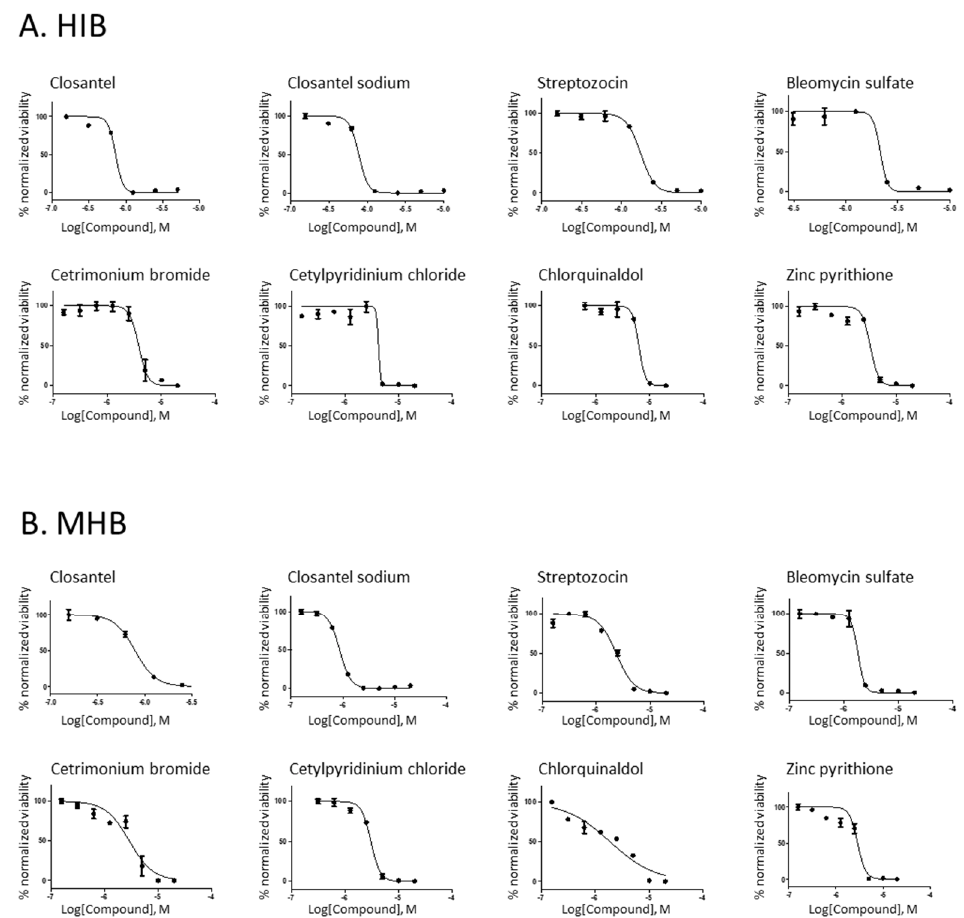
Figure 1. Concentration response curves of the inhibition of Y. pestis growth by eight nonantibiotic drugs. Eight selected compounds were tested in 8-fold dilutions ranging from 20 µM to 0.15 µM. The anti- Y. pestis activity of the selected drugs was confirmed for closantel, closantel sodium, streptozocin, bleomycin sulfate, cetrimonium bromide, cetylpyridinium chloride, chlorquinaldol and zinc pyrithione grown in ( A ) heart infusion broth (HIB) or ( B ) Mueller − Hinton broth (MHB). Data points represent the mean, and error bars represent the SEM; n = 3.